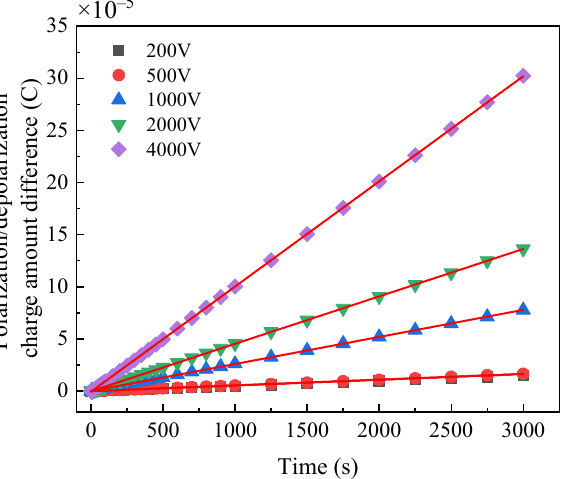
Figure 14. Polarization/depolarization charge amount difference curve of dampened oil bushing.